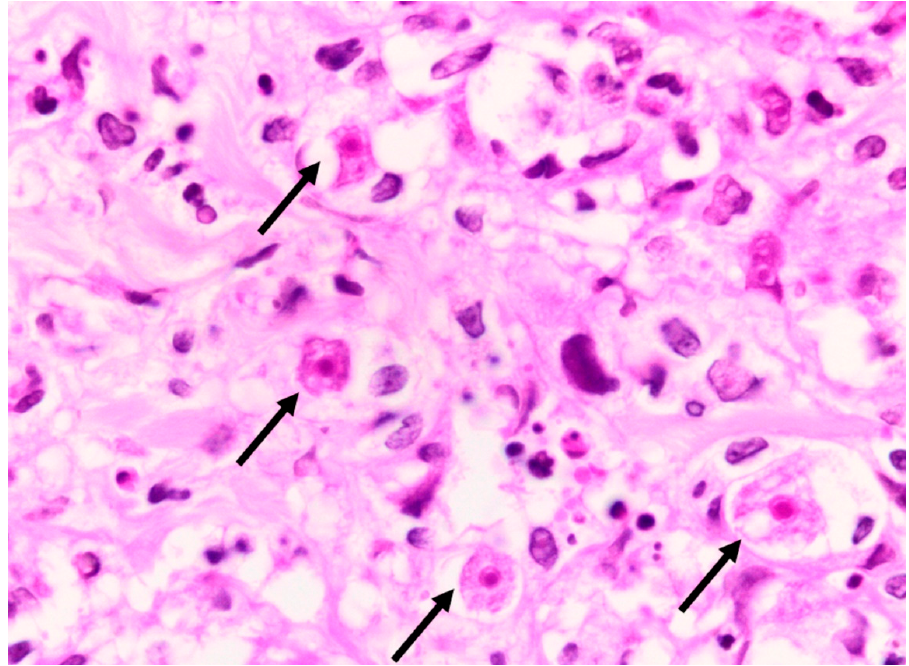
Figure 6. Acanthamoeba organisms (arrows), as seen under oil immersion. Note the characteristic targetoid appearance of the nuclei (haematoxylin and eosin, × 1000) .